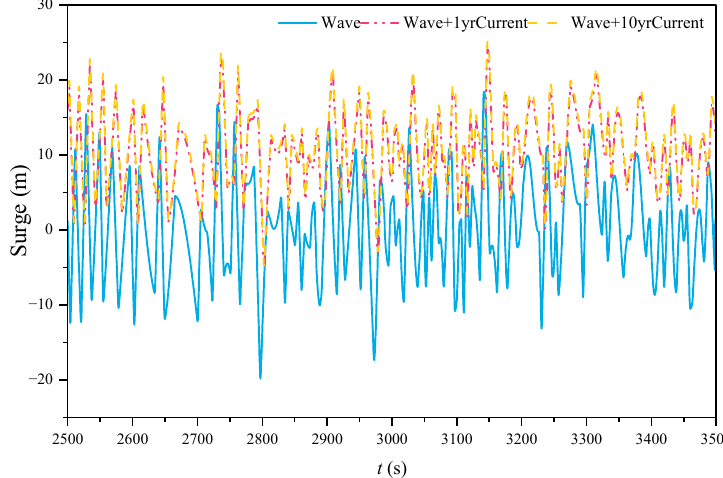
Figure 15. Surge response under wave load and current load.